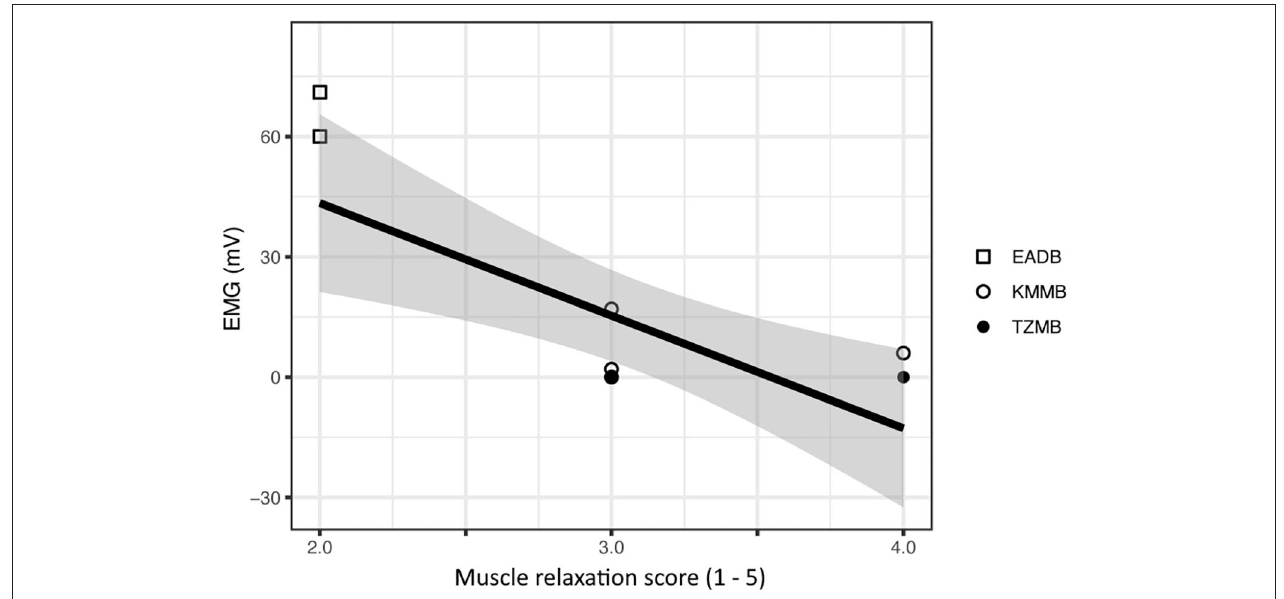
FIGURE 1 | Comparison of subjective muscle relaxation scoring and electromyography (EMG) measurements for treatment group 1 (KMMB), treatment group 2 (TZMB) and the control group (EADB). The figure presents a significant negative correlation where higher EMG values seen in the control group show low subjective muscle relaxation scores and subsequently lower EMG values that correspond to a higher subjective muscle relaxation score in the treatment